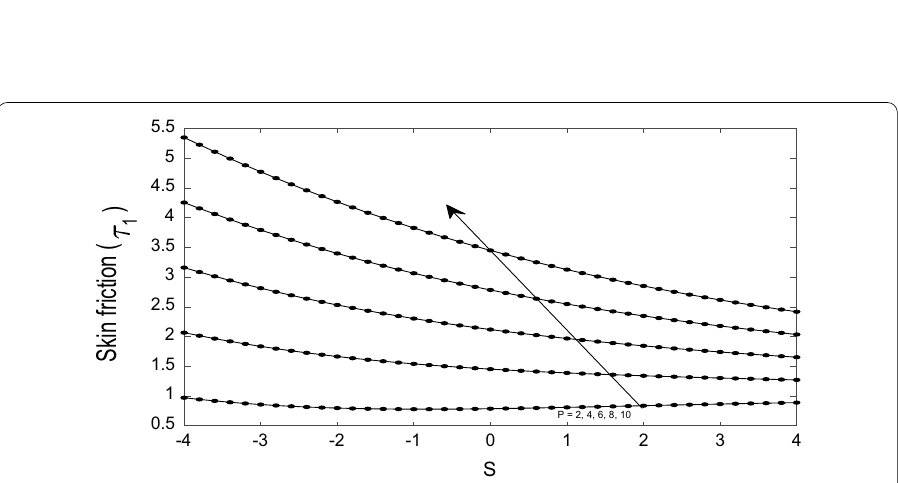
0.2, β 0.2, d 1.5, A ∗ 1, w 0.8 = = − = = =